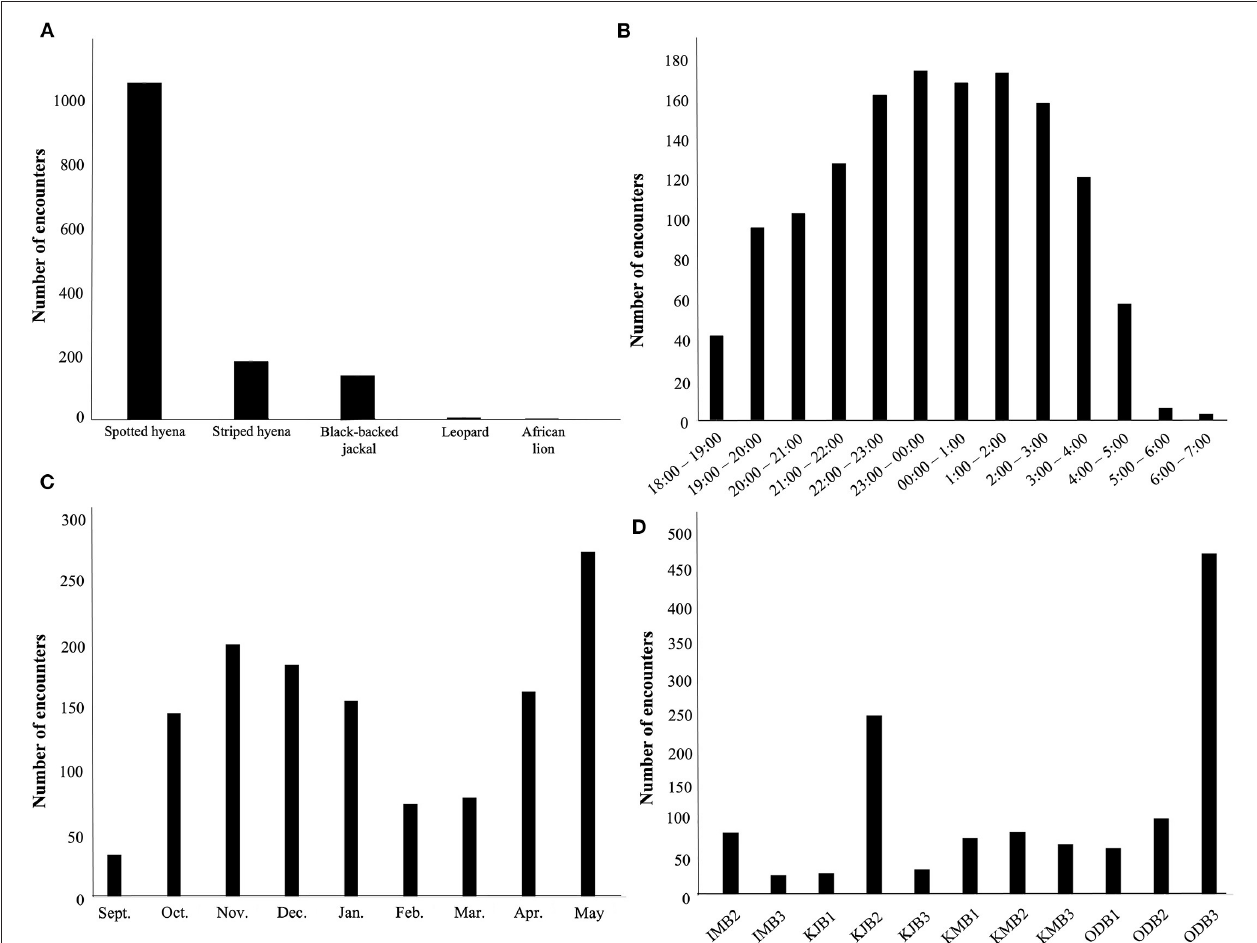
FIGURE 5 | The patterns of carnivore-livestock encounters at 12 bomas in Central Kenya from September, 2018 to May, 2019. The panels show the number of carnivore-livestock encounters by: (A) species, (B) time, (C) month, and (D) boma.